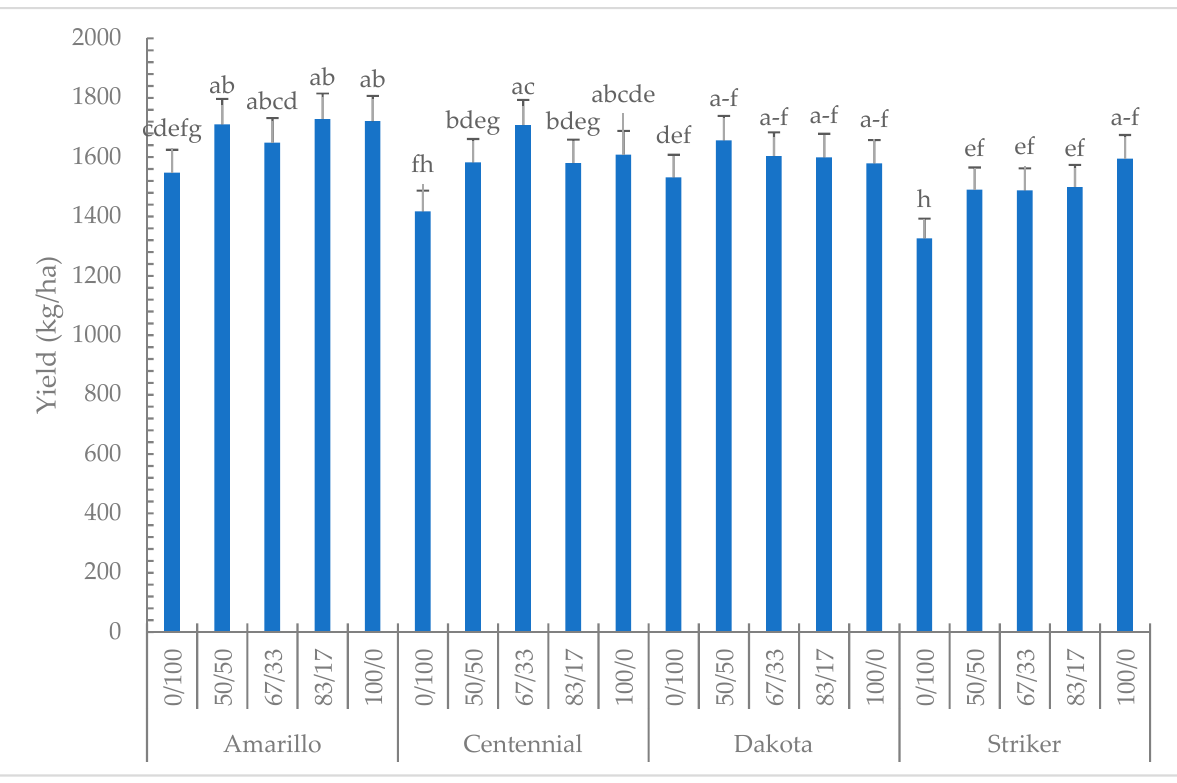
Figure 7. Interaction of variety and leaf-type mixing ratios on yield (kg ha − 1 ). Mean of five site-years, one in 2017, two in 2018, and two in 2019. Columns with different letters (a–h) representing the mean of yield were significantly different in LSD 0.05 . The error bar represents the positive standard error in LSD 0.05 . Treatments were listed as semi-leafless + leafed pea, 0/100 is leafed monoculture, for CDC Amarillo (Amarillo), CDC Centennial (Centennial), CDC Dakota (Dakota), and CDC Striker (Striker). A quadratic regression ( p < 0.001), which combined all varieties, was developed to predict the variation in yield response of the mixing ratios (Figure 8). Regression analysis revealed that the mixture of 86:14 SL/L ratio had the highest yield, providing an 11% yield increase above the leafed monoculture, yet no difference in yield in comparison to the semi-leafless monoculture (Figure